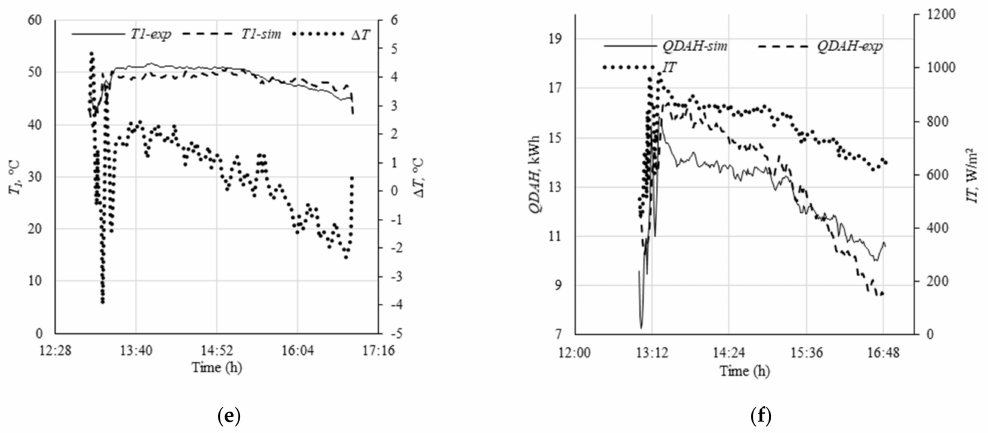
Figure 5. T 1 and Q DAH theoretical–experimental